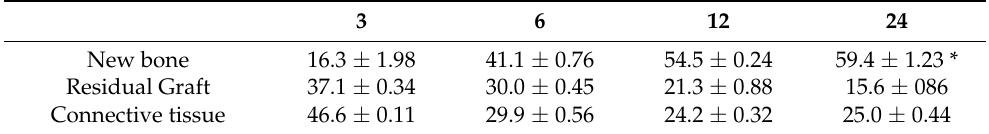
Table 1. New bone formation at 60